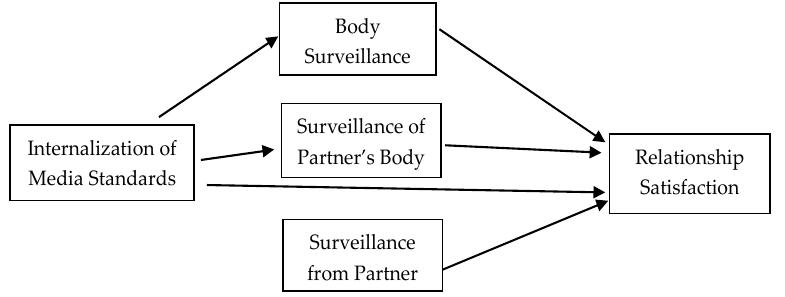
Figure 1. The hypothesized model .